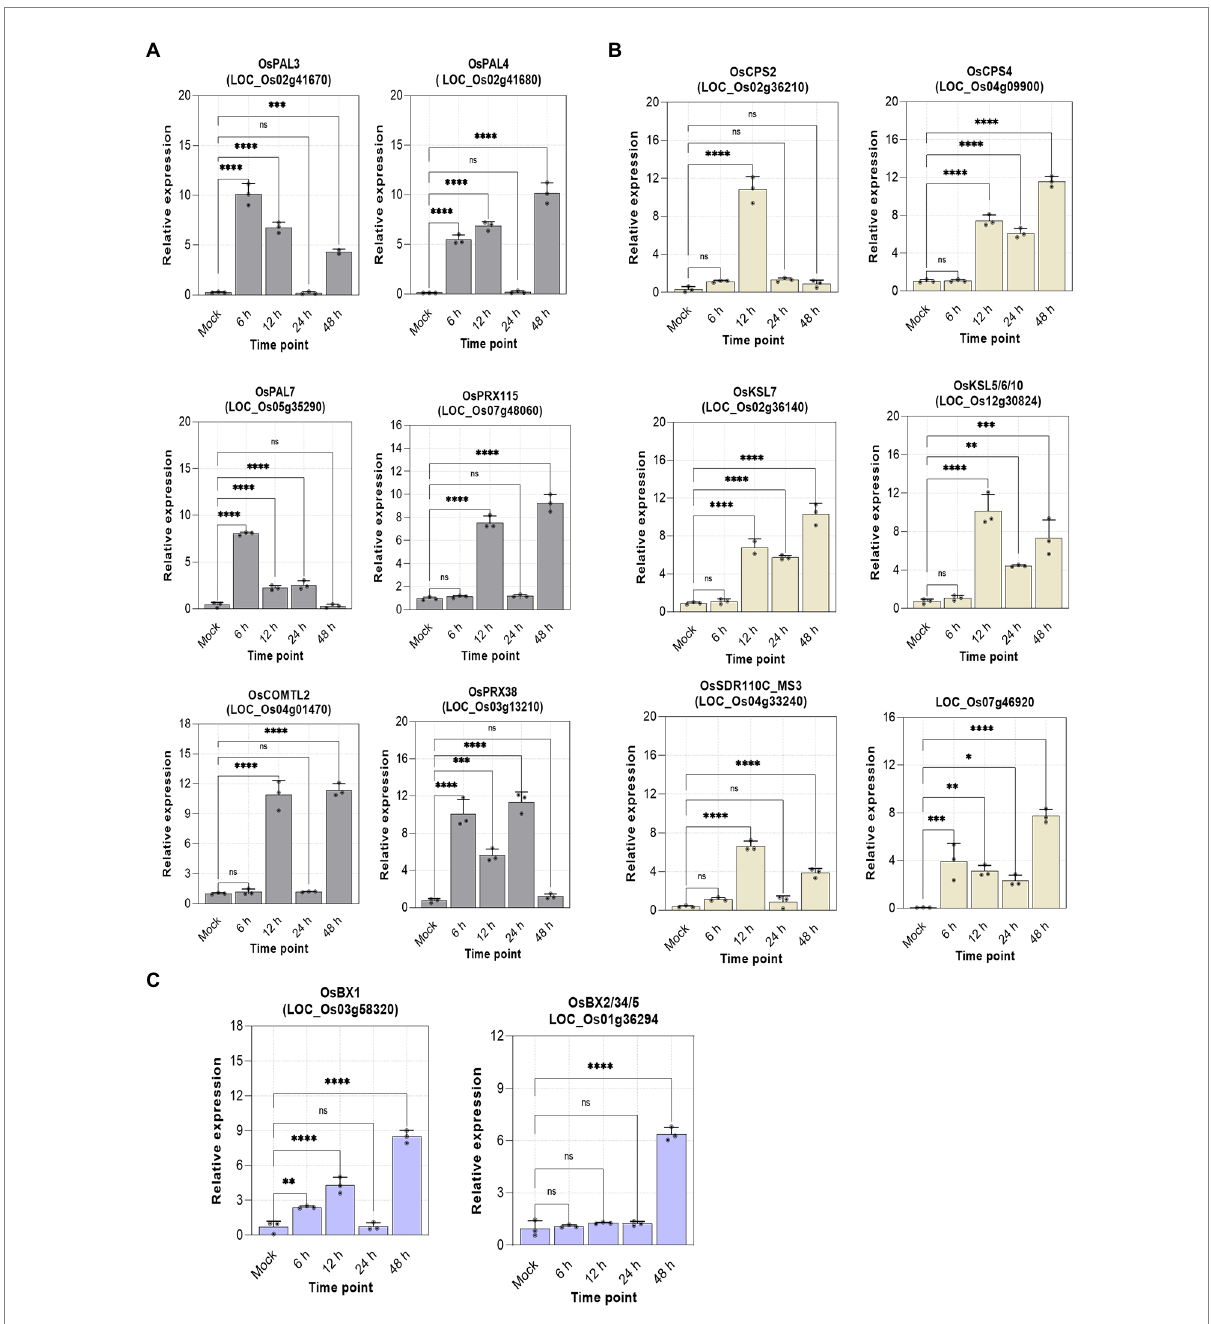
FIGURE 6 Relative expression of selected genes. n = 3, error bars = mean ± sd, p -value >0.01( * ), p -value >0.001( ** ), p -value >0.0001( *** ), and p -value >0.00001( **** ) at 95% confidence interval. (A) Lignin genes; (B) diterpenoids genes; (C) benzoxazinoids